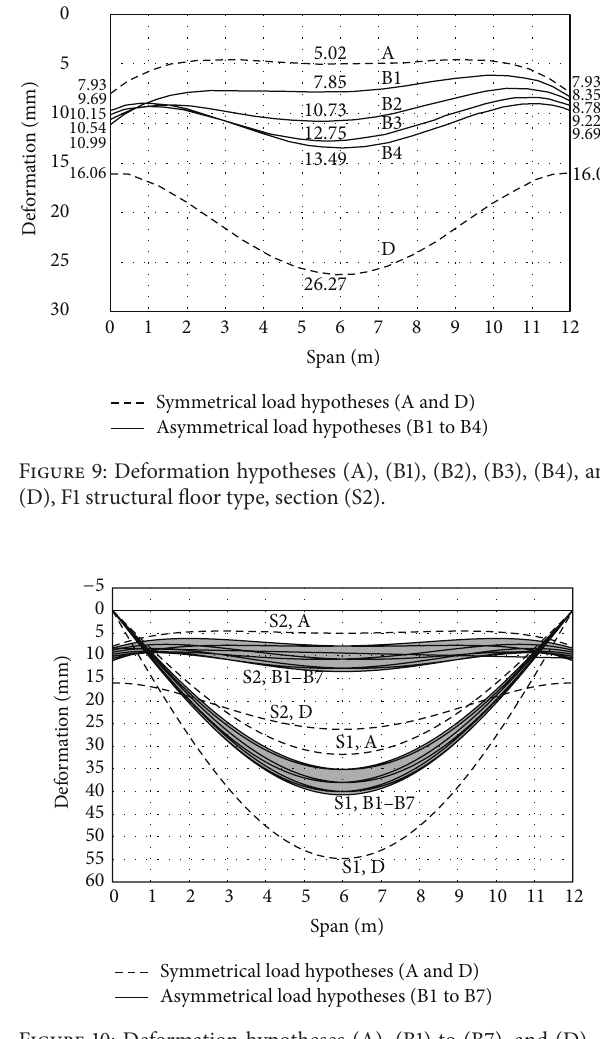
The (A) and (D) hypotheses are also represented which cor- respond to the quasipermanent situation and total load,